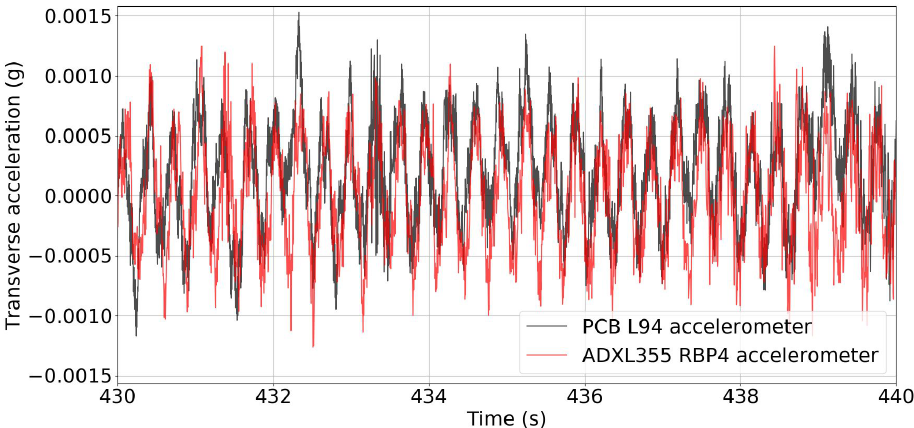
Figure 26. Transverse ambient vibration record of the railway bridge on measurement channel